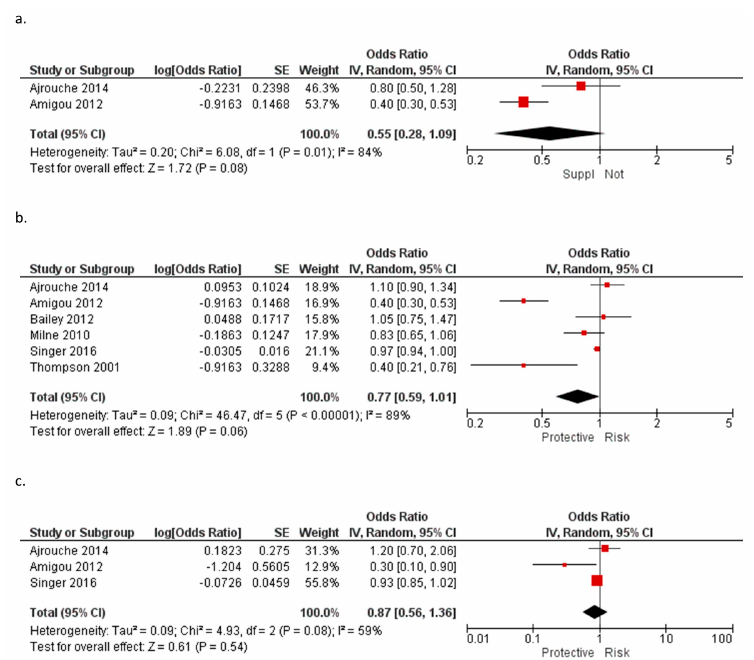
Figure 3. Meta-analysis of the association between the supplementation with folic acid during pregnancy and ( a ) acute leukemia [40,41], ( b ) acute lymphoblastic leukemia [28,29,40,41,43,45] and ( c ) acute myeloid leukemia [29,40,41]. Note: the individual estimate (OR) from the studies are represented by the red box, and the black diamond represent the estimate of the